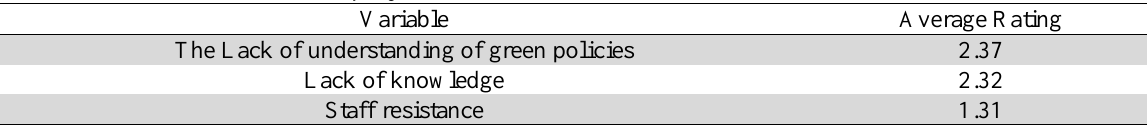
Results of Friedman test for